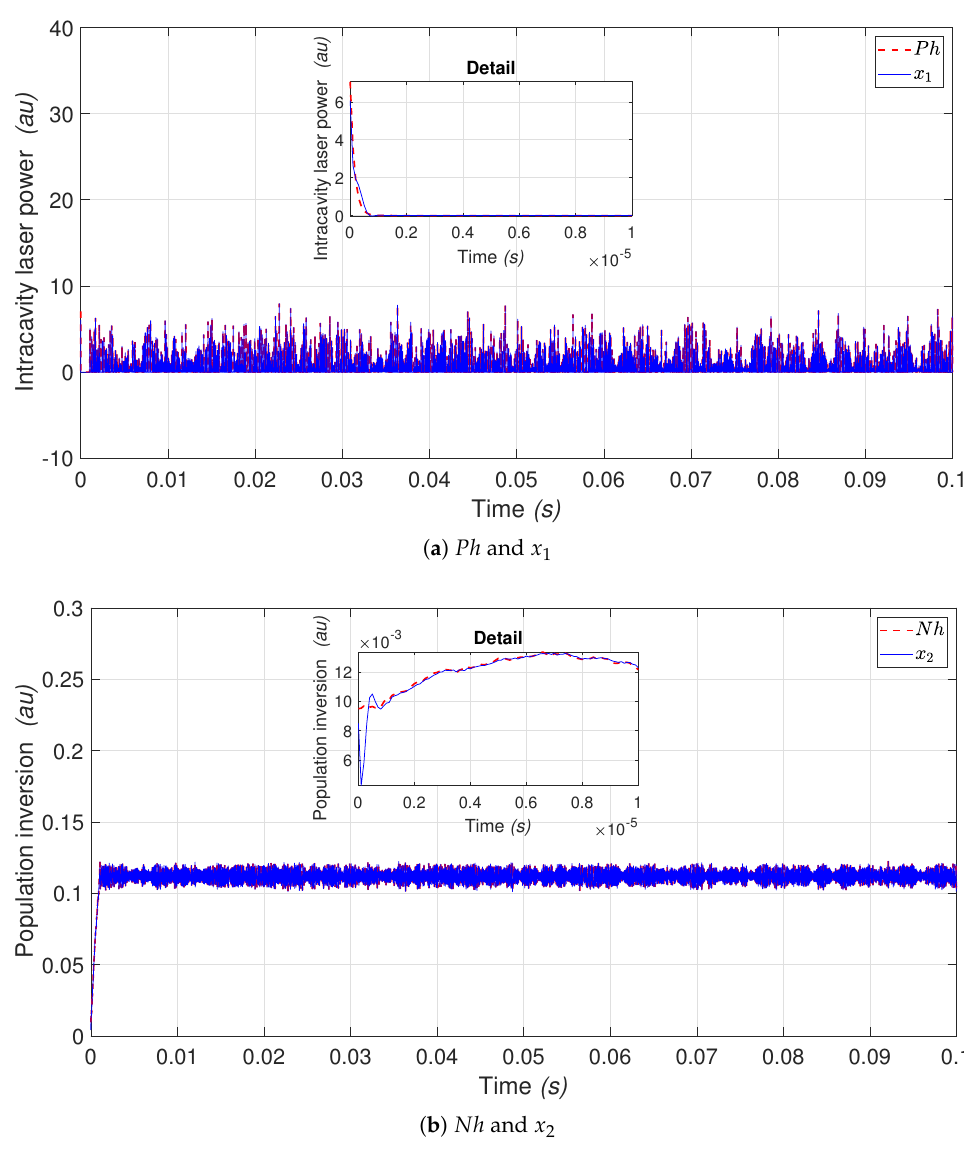
Figure 8. ( a ) Intracavity laser power Ph and neural identification x 1 behavior. ( b ) Population inversion Nh and neural identification x 2